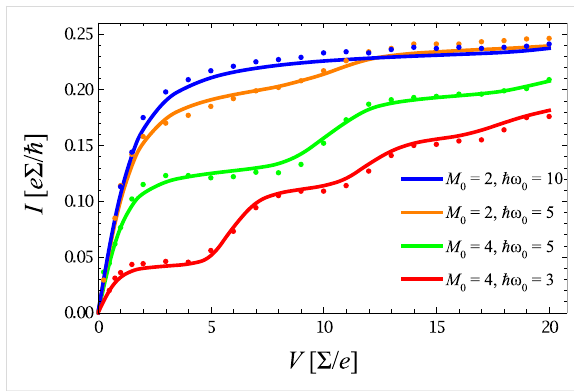
Figure 9: As Figure 6, but for nonequilibrated phonons based on an extended master equation (solid) in comparison to exact diagMC data (dots).